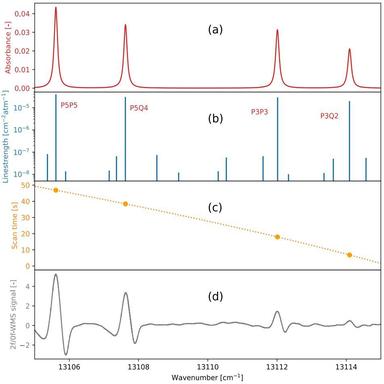
Simulated absorbance (a), line strength (b) and spectral calibration curve (c) corresponding to the typical trace of 0f-normalized GASMAS (2f-WMS) signal obtained for the experimental scenario C performed with 100% air contained within the cell (d).